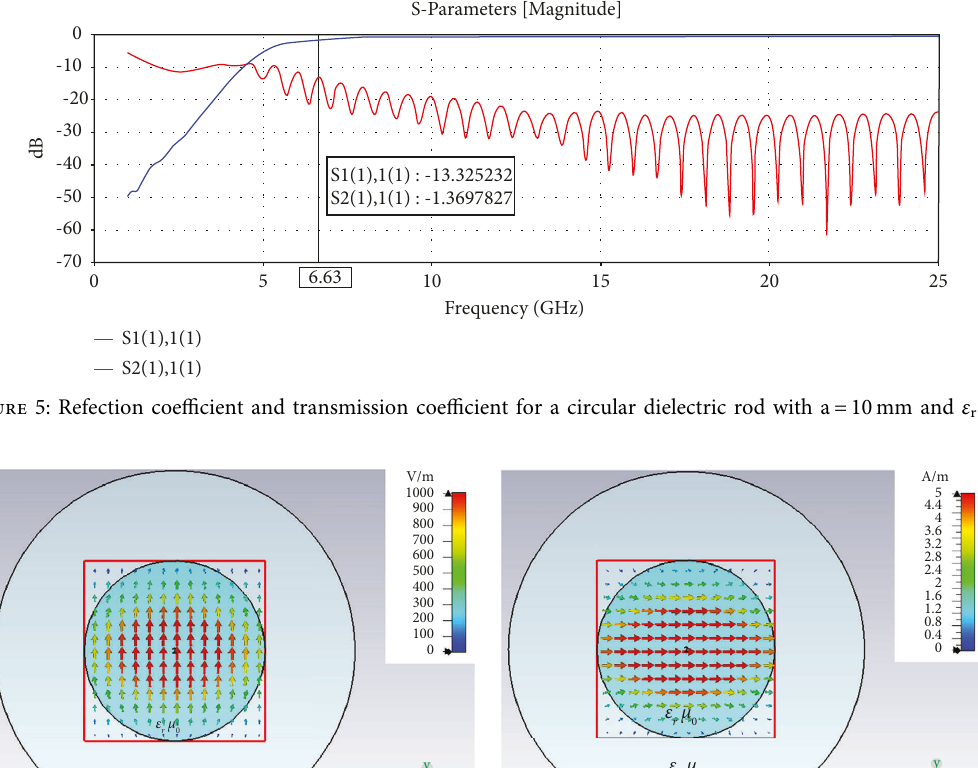
Figure 6: (a) Electric field distribution and (b) magnetic field distribution of the first simulation